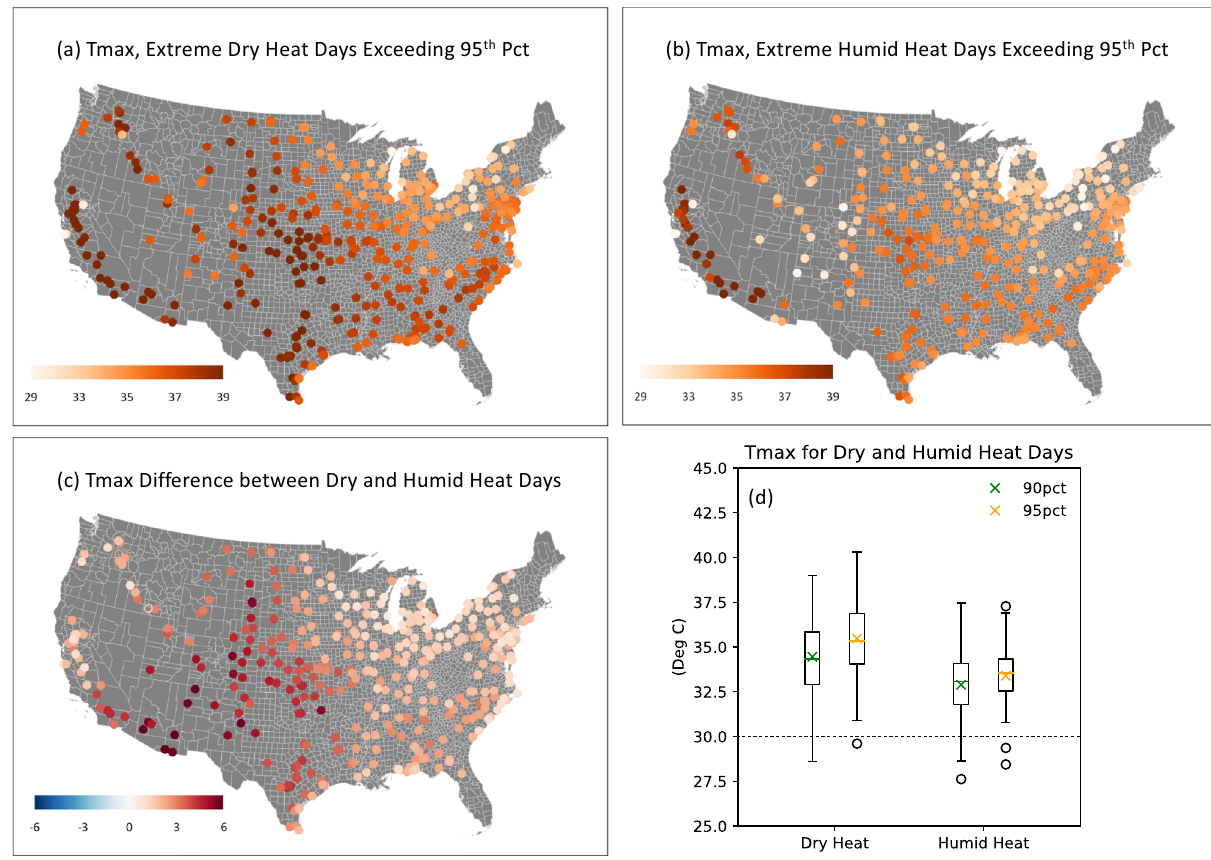
Figure 5. Average Tmax for extreme Dry and Humid Heat Days for the U.S. corn growing regions. ( a ) Average Tmax for all extreme dry heat days exceeding the local 95th percentile of Tmax, but not exceeding the local 95th percentile of Twmax, ( b ) average Tmax for all extreme humid heat days exceeding the local 95th percentile of Twmax, and ( c ) differences between average Tmax for dry and humid heat days ( a , b ), for the period 1979–2019. ( d ) Box plots for the distribution of mean Tmax above the 90th (green) and 95th (orange) percentiles at stations with significant corn yield losses due to dry heat (significant negative regression coefficients in Figs. 3a and S5a). Boxes and whiskers show the interquartile range and data range, respectively, of average Tmax for dry (left) and humid (right) heat days. The cross markers and horizontal lines inside the boxes represent the mean and median, respectively, and open circles are outliers. The maps are made with ArcGIS Pro 2.2.0 with the US base map downloaded from Census Bureau, https:// catal og. data. gov/ datas et/ 2019- carto graph ic- bound ary- shape file- curre nt- census- tract- for- united- states- 1-